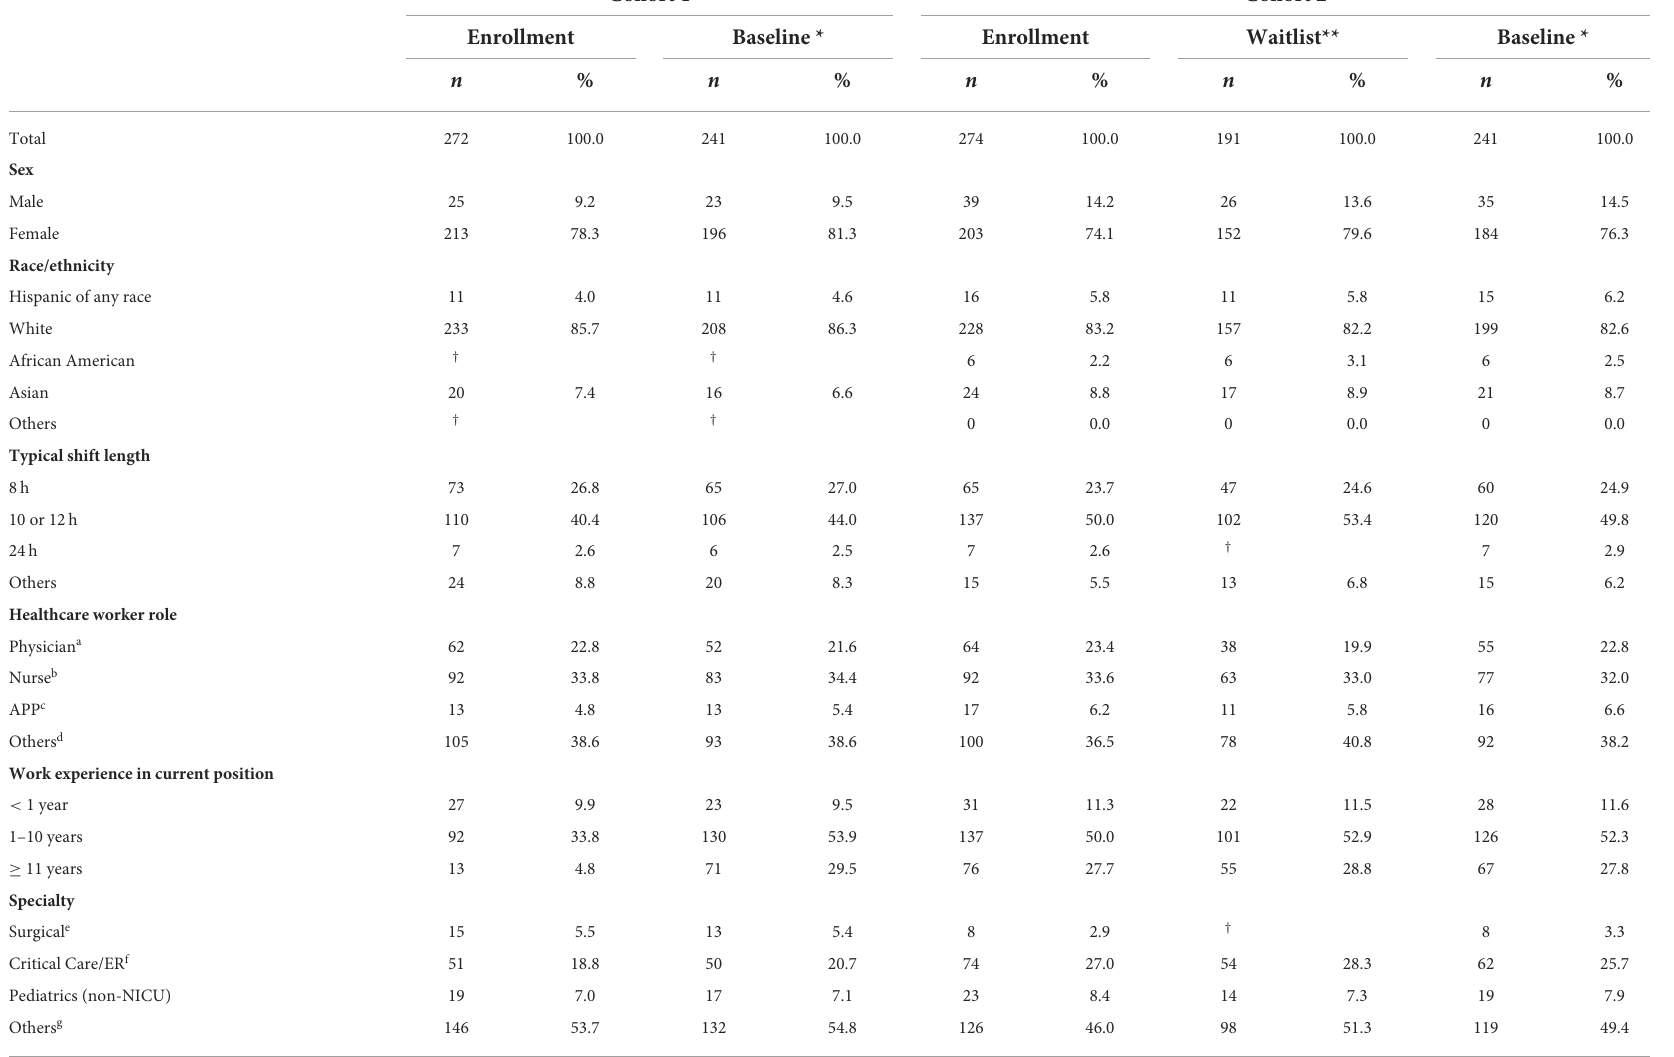
TABLE 1 Characteristics of the study population before